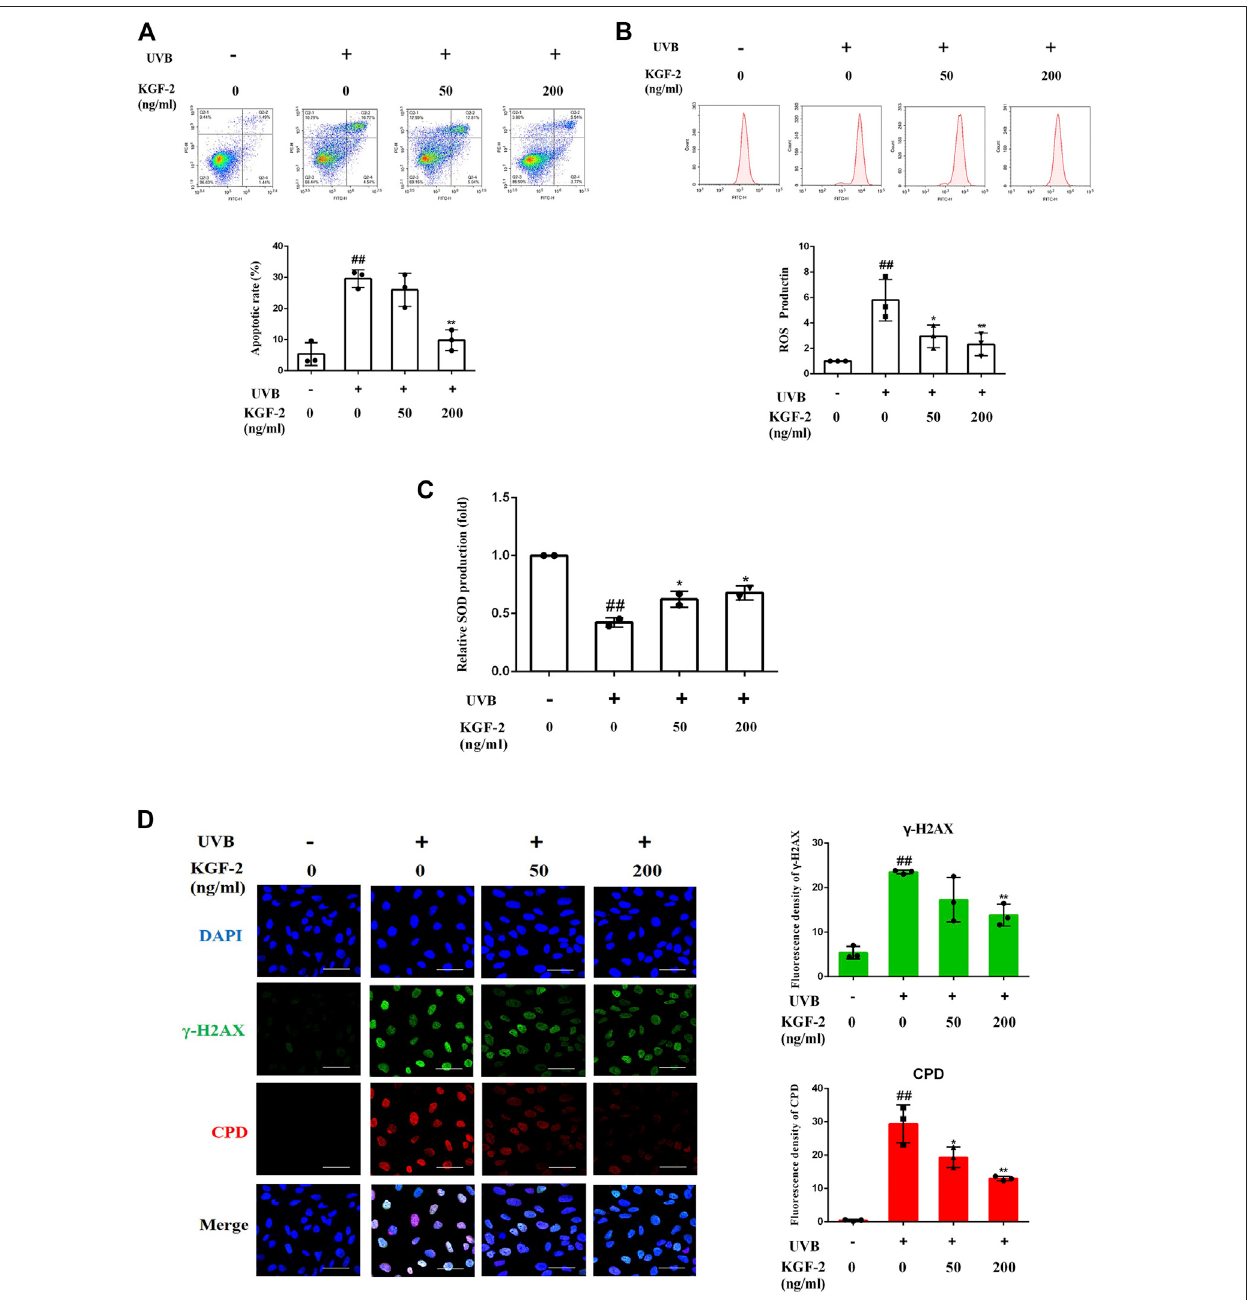
FIGURE2| EffectsofKGF-2ontheapoptosis,ROS,andSODproductionaswellasDNAdamageofUVB-irradiatedHaCaTcells.HaCaTcellswereincubatedwith KGF-2(0,50,200 ng/ml)for4 h,thenexposedtoUVB(200 mJ/cm 2 )andfurtherincubationfortheindicatedtimes. (A) FlowcytometryanalysisofapoptoticHaCaTcells stained with Annexin V/PI after 6-h incubation following UVB irradiation, the plot compares the apoptotic rate from three different treatments. UVB only vs. untreated control group, p (cid:2) 0.0002; KGF-2 (50 ng/ml) vs. UVB only group, p (cid:2) 0.5635; KGF-2 (200 ng/ml) vs. UVB only group, p (cid:2) 0.0007. (B) Intracellular ROS levels as measured by fl ow cytometry using the oxidant-sensitive probe DCFH-DA after 1-h incubation following UVB irradiation, the plot compares the relative ROS production from three different treatments. UVB only vs. untreated control group, p (cid:2) 0.0012; KGF-2 (50 ng/ml) vs. UVB only group, p (cid:2) 0.0242; KGF-2 (200 ng/ml) vs. UVB only group, p (cid:2) 0.0084. (C) TheSODlevelsweremeasuredafter6-hincubationfollowingUVBirradiation.UVBonly vs. untreatedcontrolgroup, p (cid:2) 0.0008 ; KGF-2(50 ng/ml) vs. UVBonlygroup, p (cid:2) 0.0385;KGF-2(200 ng/ml) vs. UVBonlygroup, p (cid:2) 0.0168. (D) Representativeimageofimmuno fl uorescencestainingofCPDand γ -H2AXwere obtainedafterincubatingfor1-hfollowingUVBirradiation,theplotcomparestheformationofCPDand γ -H2AXfromthreedifferenttreatments.For γ -H2AX,UVBonly vs. untreated control group, p (cid:2) 0.0002; KGF-2 (50 ng/ml) vs. UVB only group, p (cid:2) 0.0703; KGF-2 (200 ng/ml) vs. UVB only group, p (cid:2) 0.0085. For CPD, UVB only vs. untreated control group, p < 0.0001; KGF-2 (50 ng/ml) vs. UVB only group, p (cid:2) 0.0132; KGF-2 (200 ng/ml) vs. UVB only group, p (cid:2) 0.0007. All graphical data are the means ± SD from three independent experiments, “ # ” and “ ## ” indicate signi fi cantly different from the untreated control group at the p < 0.05 and p < 0.01 levels, respectively, “ * ” and “ ** ” indicate signi fi cantly different from the UVB only control group at the p < 0.05 and p < 0.01 levels, respectively.